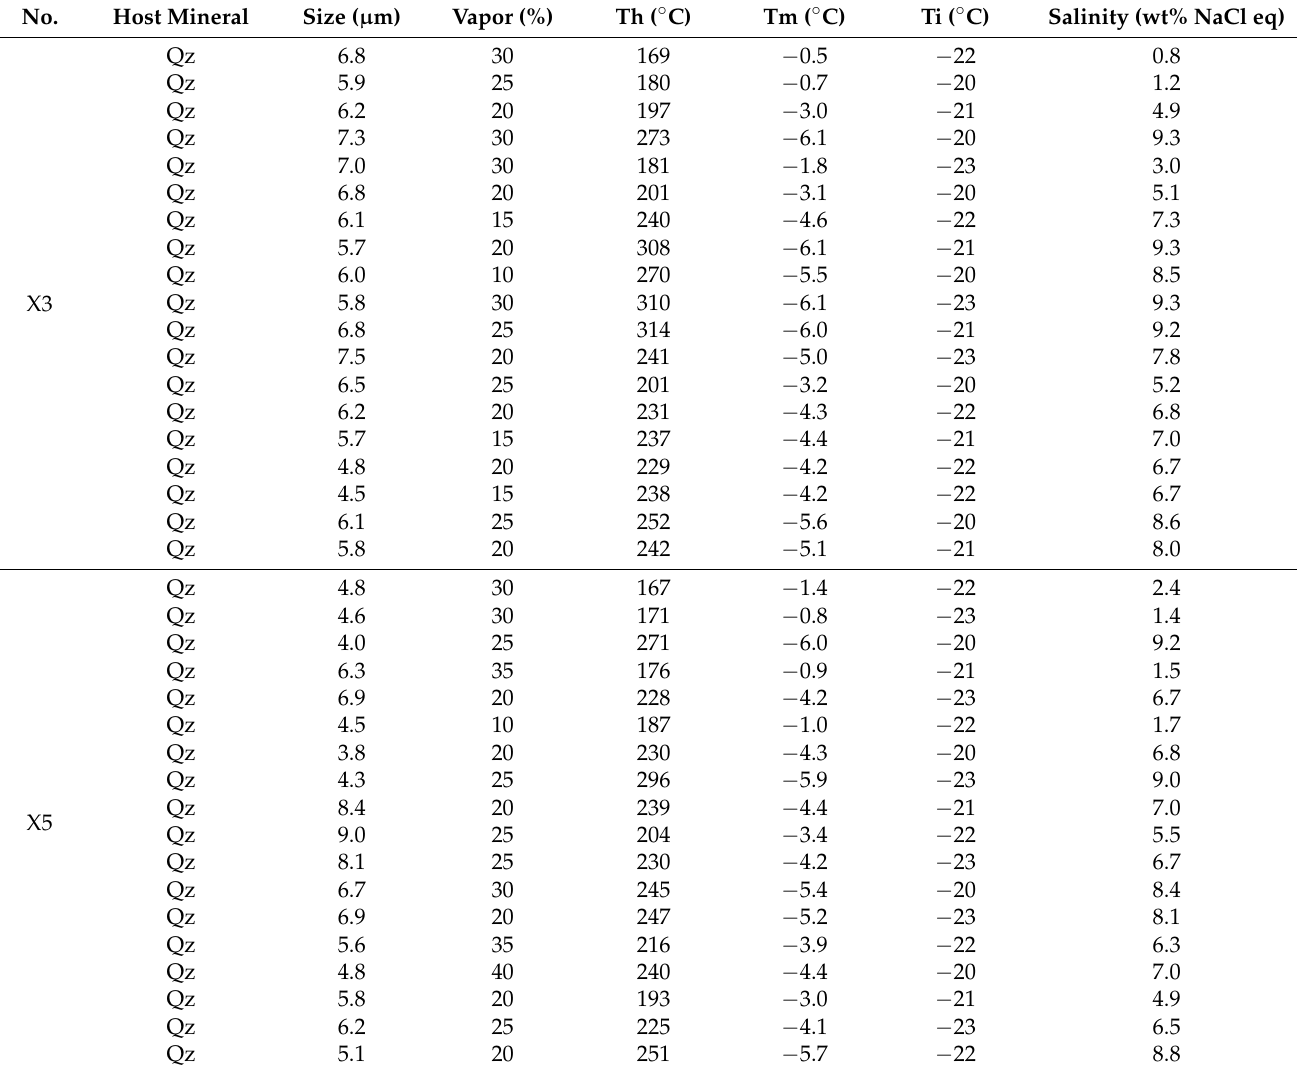
Table A2. Microthermometry results of primary fluid inclusions in Stage II of Xiaojiashan gold